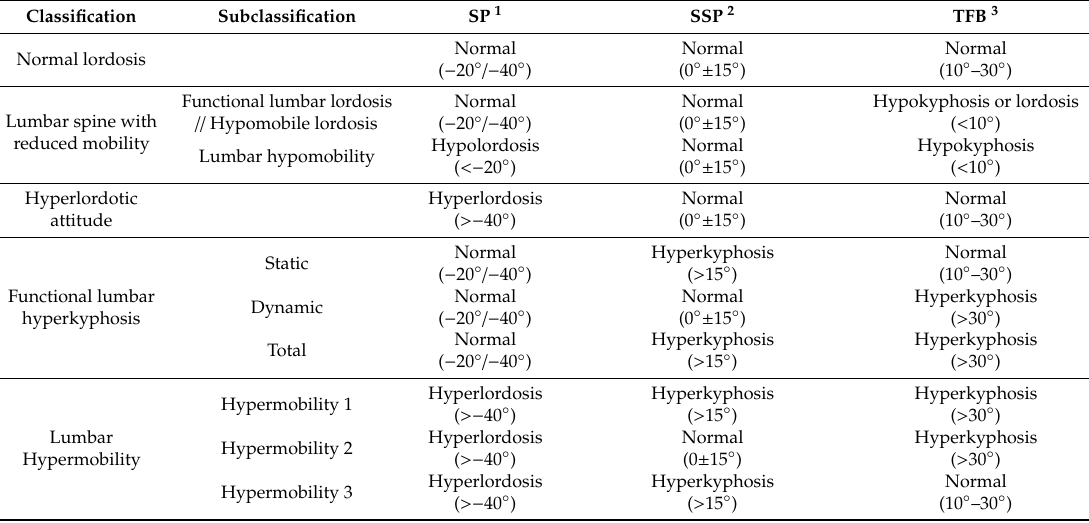
Table 3. Diagnostic classification for the “Sagittal Integral Morphotype” for the lumbar